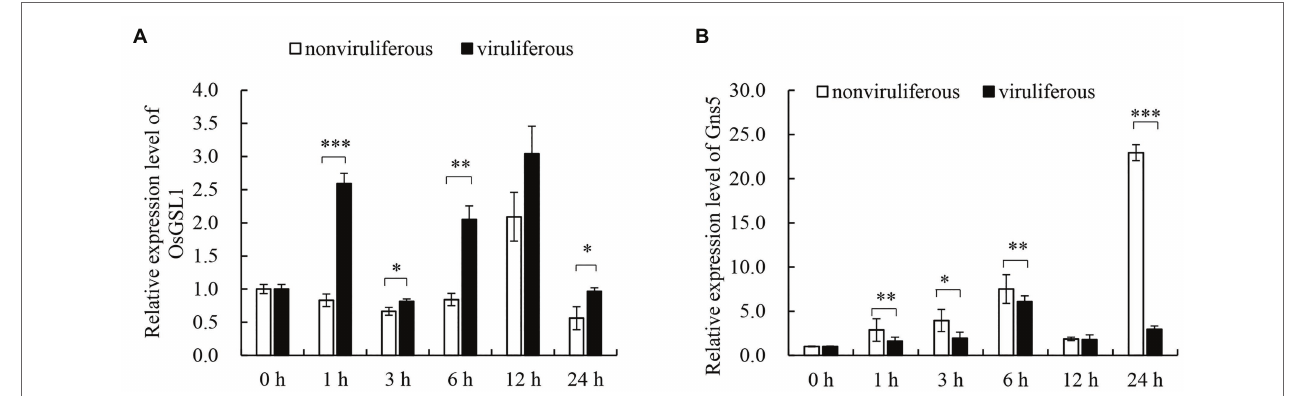
FIGURE 6 | Real-time RT-PCR assay of the callose synthase and callose hydrolyzing genes in response to R. dorsalis feeding. The callose synthase-encoding gene GSL1 (A) and callose hydrolase-encoding gene Gns5 (B) were analyzed. Total RNA was extracted from rice leaf sheaths after different R. dorsalis feeding times. Expression of genes was quantified relative to the value obtained from 0 h samples ( R. dorsalis -free plants). Each bar represents the mean ± SE of three replicates. Each RNA sample was extracted from approximately 100 mg of fresh leaf sheaths of five rice plants. Rice actin gene was used as a reference control. Significant differences in gene expression are denoted as * ( p , 0.05), ** ( p , 0.01), or *** ( p , 0.001); student’s t